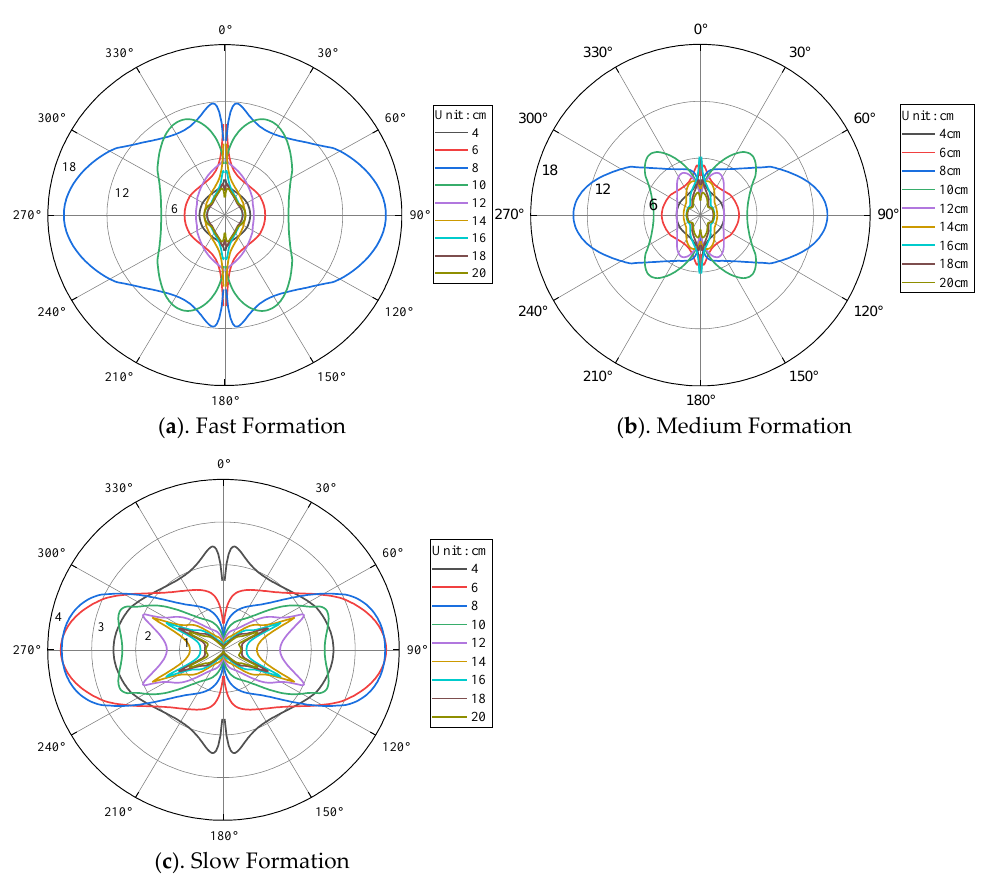
Figure 10. Radiation characteristics of SH–wave of a dipole source under different borehole radii with the main frequency of the dipole source 5 kHz.